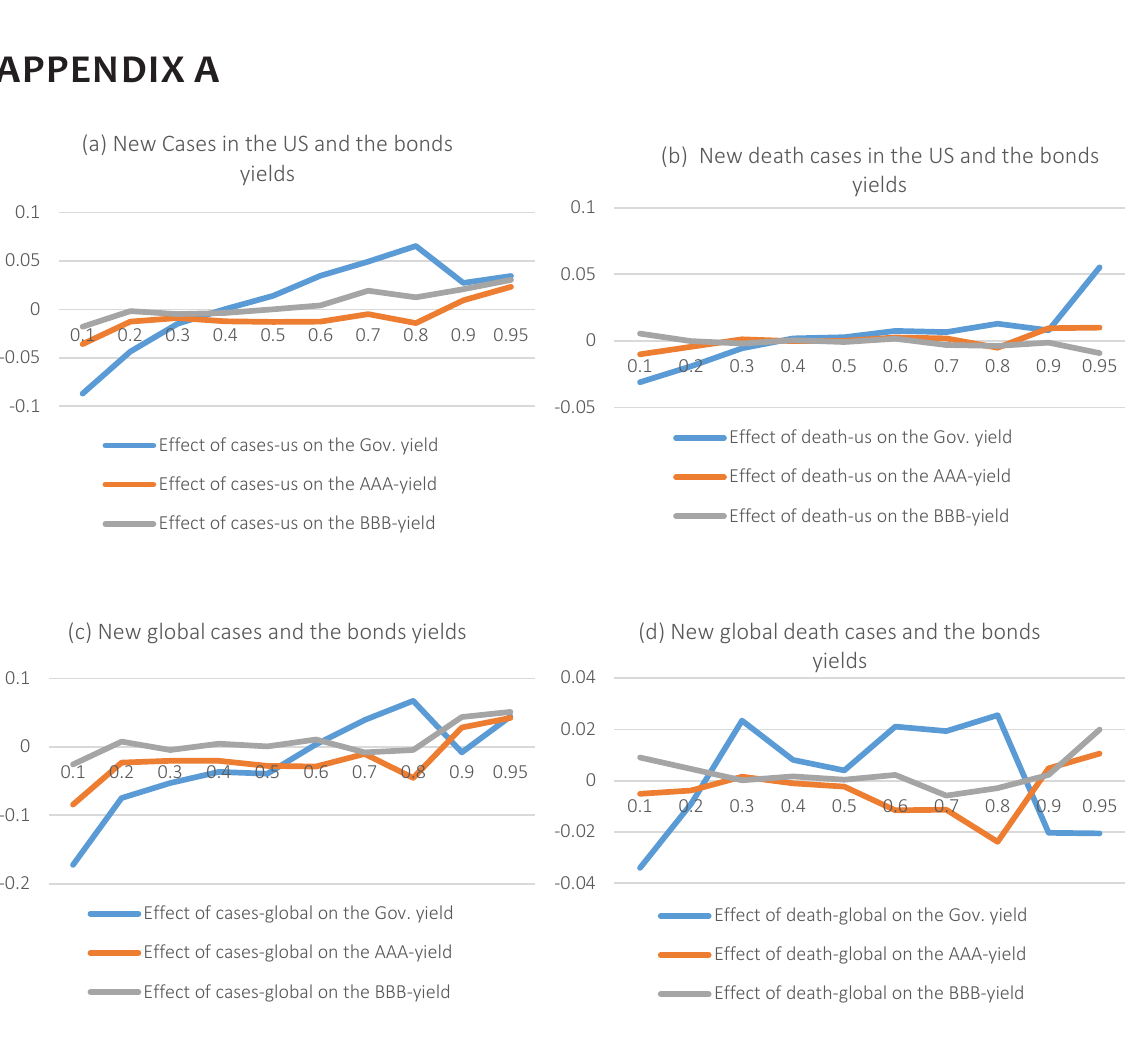
Figure A1. COVID-19 and bond